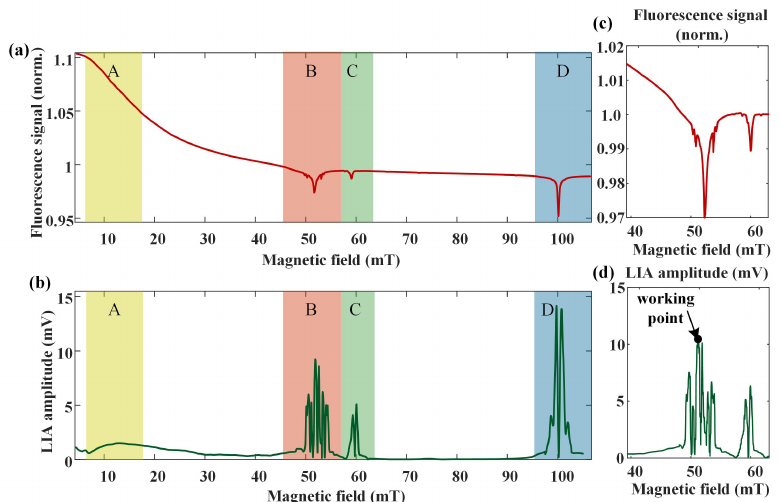
Figure 2. ( a ) Photoluminescence (PL) of nitrogen-vacancy (NV) centers as a function of the back- ground magnetic field. The four areas A, B, C and D that can be exploited for magnetometry indicate features due to spin mixing, cross relaxation between NV centers and P1 centers, cross relaxation with NV centers that are not aligned along the magnetic field, and ground state level anticrossing, respectively. ( b ) Corresponding amplitude of lock-in amplifier (LIA) referenced at 100Hz for those features. ( c ) Zoomed-in B area of ( a ), PL recorded with field-modulation depth of 0.48mT at 100Hz. ( d ) Zoomed-in B area of ( b ), indicating the working point at